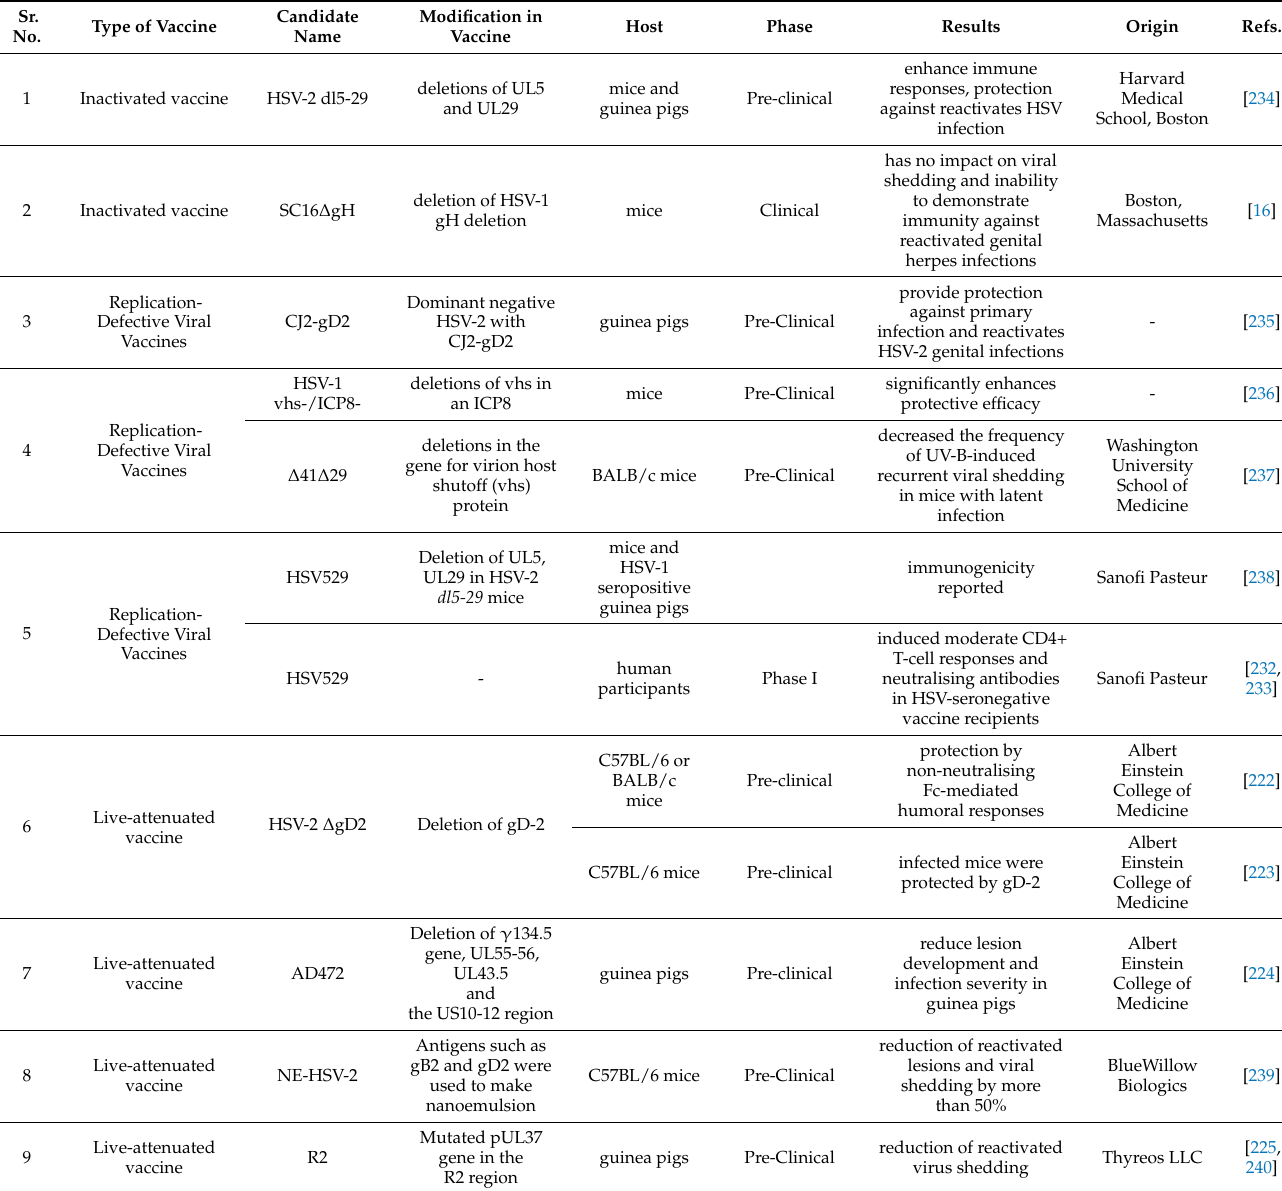
Table 2. Vaccination strategies for the prevention of HSV-1 and HSV-2